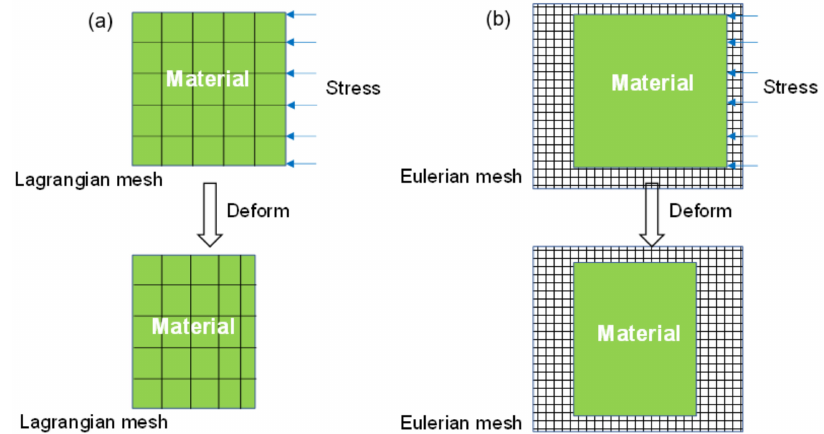
Figure 2. Sketch of: ( a ) Lagrangian Mesh; and ( b ) Eulerian Mesh.